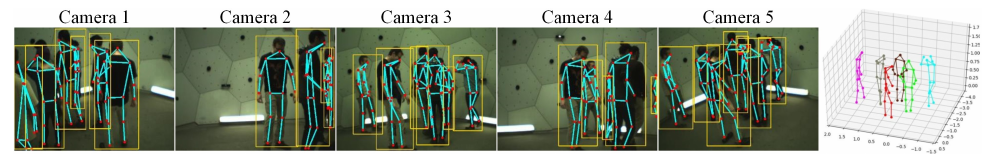
( a ) Multi-person 3D pose estimation on CMU panoptic dataset.